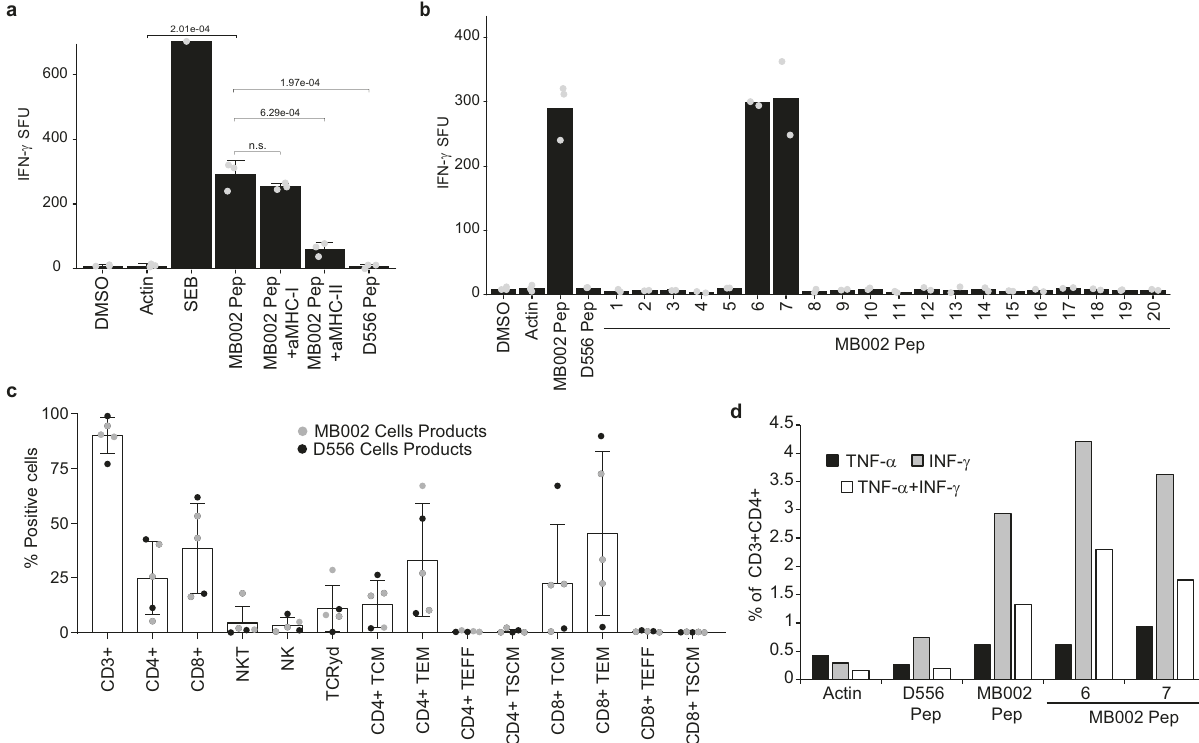
Fig. 5 MB002 cell line-speci fi c peptides induce peptide-speci fi c, poly-functional Class II-mediated T cell IFN- γ responses in vitro. Dendritic cells were loaded with MB002-speci fi c peptides and co-cultured with non-adherent PBMCs. After three stimulations, peptide-speci fi c T cell responses were analyzed by anti-IFN- γ ELISpot. a Summary data of IFN- γ response to pooled MB002 peptides in healthy donor 1. One-sided t-test was used to calculate the p - values, n = 3. p -values are indicated in the fi gure. b Summary data showing IFN- γ response to individual MB002 peptides in healthy Donor 2 ( n = 2). c Summary data of MB002 and D556 TSATs populations and phenotypes (Error bars: mean + SD of fi ve independent experiments). d Summary data showing CD4 + cytokine response to the pooled MB002 peptides and to the individual peptides 6 and 7 in the healthy donor 2. SFU: spot-forming units; 1 SFU = 1 T cell secreting IFN- γ ; TSA T: Tumor-speci fi c antigen T cell; a-MHC-I/II: anti-MHC Class I/II blocking antibodies; MB002 pep: pooled MB002 peptides; D556 pep: pooled D556 peptides; DMSO: dimethyl sulfoxide (peptide solvent; unstimulated control); actin: peptide speci fi city control; SEB: staphylococcus enterotoxin B (positive control). Gating strategy for intracellular staining (Supplementary Fig. 15). Gating strategy TSA T populations